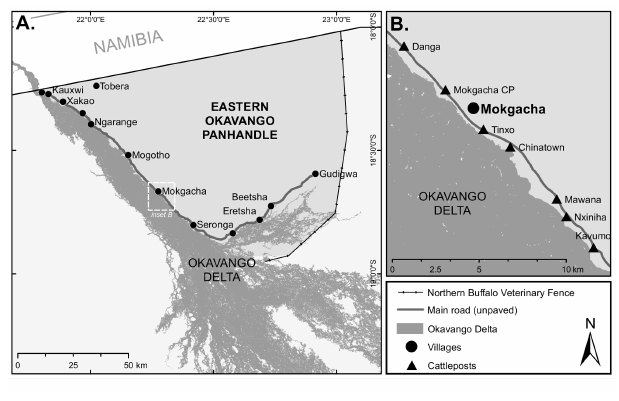
Fig. 1 . Map of study site showing the villages of the Eastern Panhandle of the Okavango Delta (inset A), as well as the study village, Mokgacha, with cattleposts (inset B).